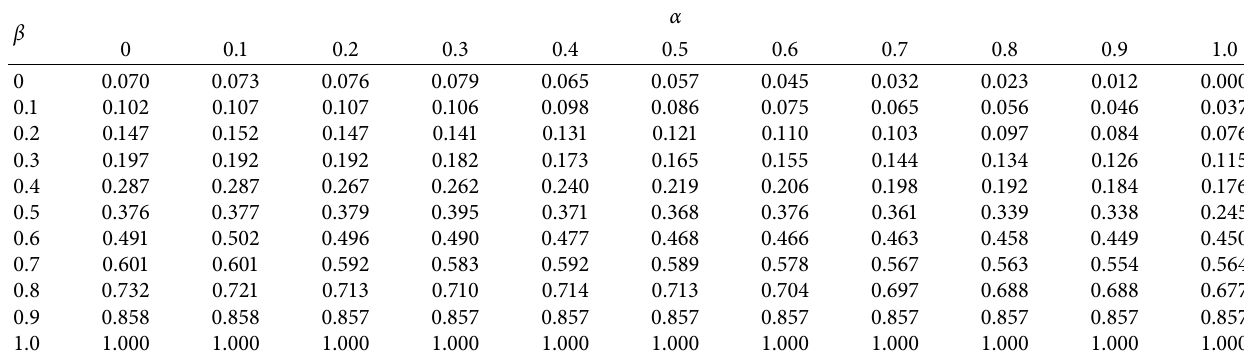
Table 9: Normalization of road network reserve capacity.